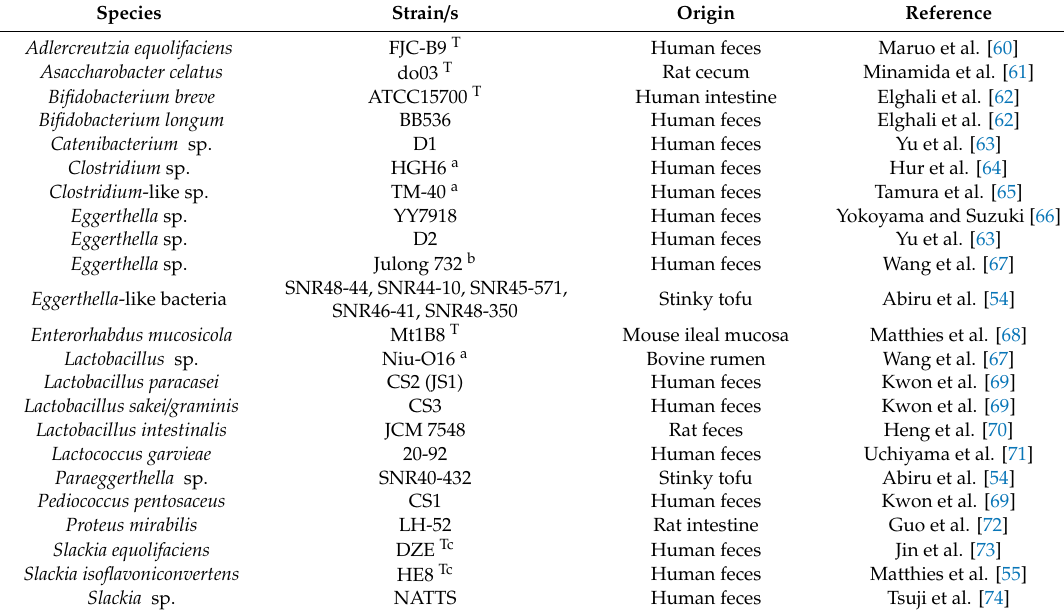
Table 1. Bacterial species and strains involved in the metabolism of equol or its intermediate precursors from